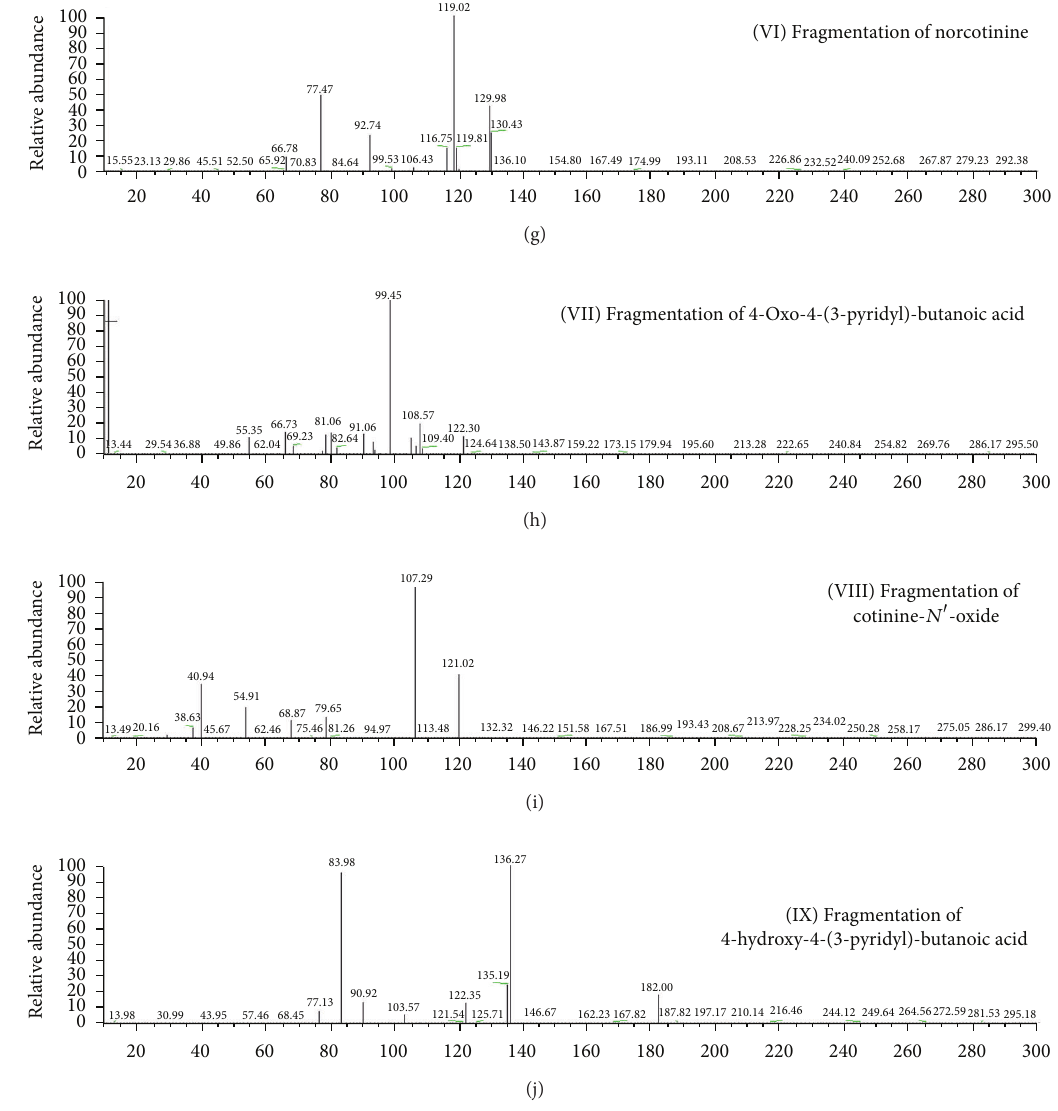
Figure 3: Electrodeless electrochemical oxidation (EEO) method coupled with UHPLC-MS/MS showed the spectra of the nicotine and its derivatives labeled with I–IX. The spectra displayed (a) base peak chromatogram and fragmentation pattern of nicotine (b), cotinine (c), trans -3 󸀠 -hydroxyl cotinine (d), nornicotine (e), nicotin- N -oxide (f), norcotinine (g), 4-oxo-4-(3-pyridyl)-butanoic acid (h), 4-hydroxy-4-(3- pyridyl)-butanoic acid (i), cotinine- N 󸀠 -oxide (j).